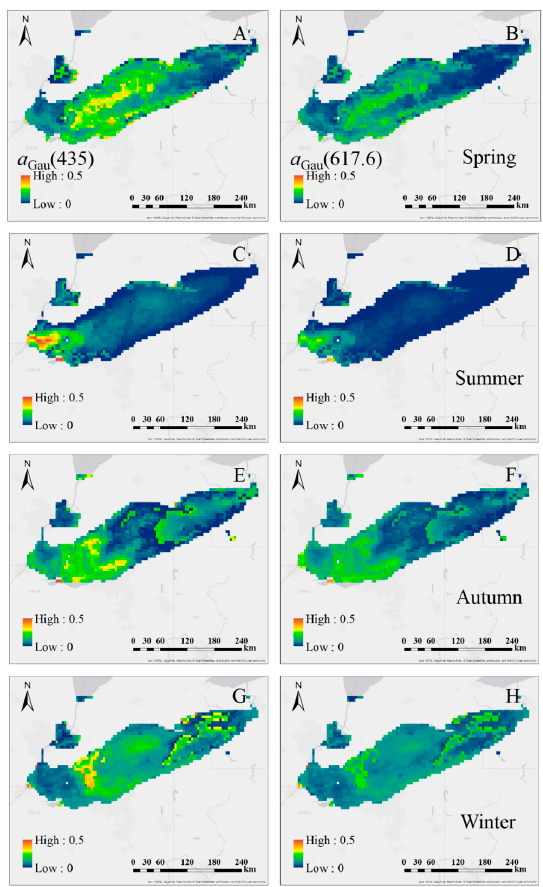
Figure 13. The distribution of a Gau (435) and a Gau (617.6) in Lake Erie in: spring ( A , B ); summer ( C , D ); autumn ( E , F ); and winter ( G , H